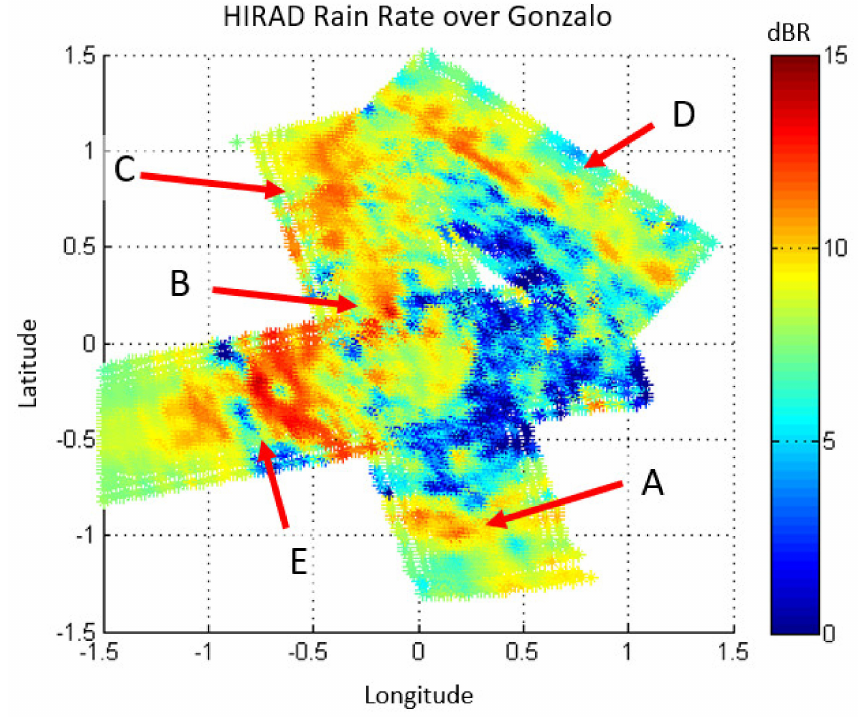
Figure 18. HIRAD-retrieved RR in dBR, where locations of interest ( A – E ) are marked in ascending alphabetical